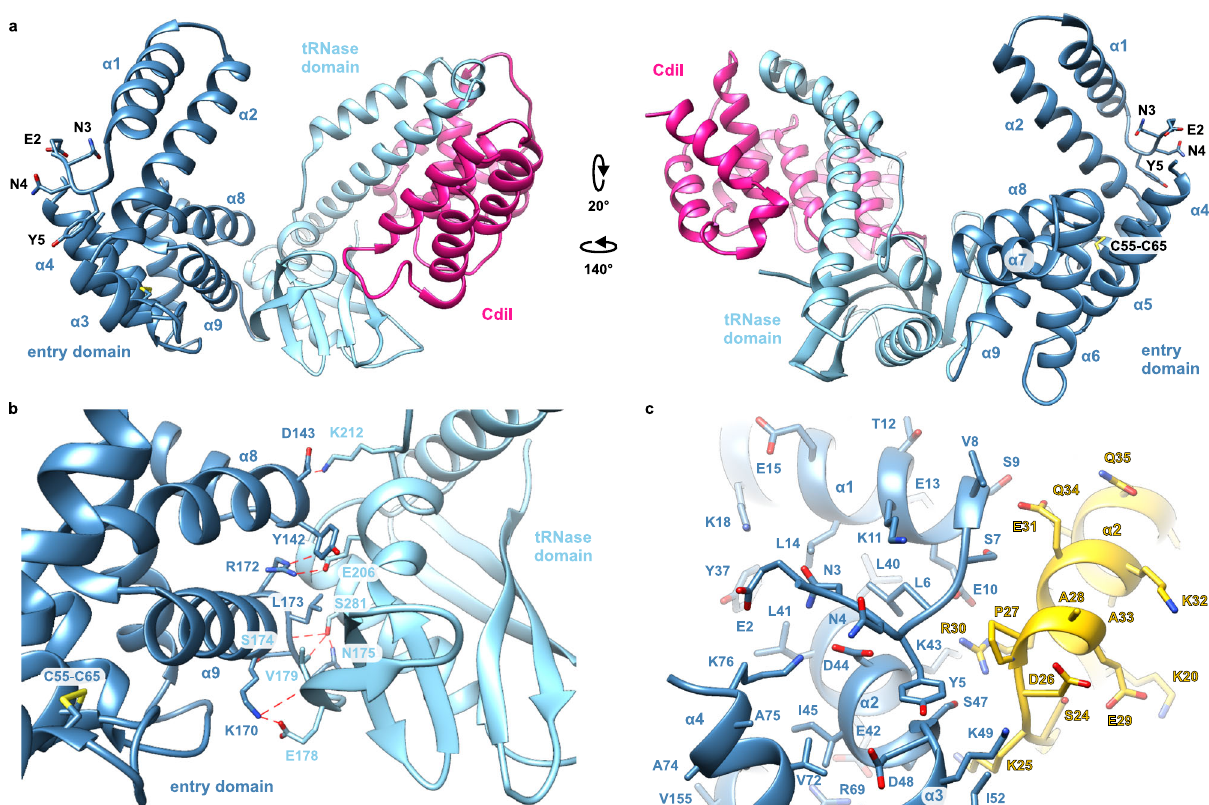
Fig.2|StructureofthePtsG-dependentcytoplasm-entrydomain.a Structureof the CdiA-CT (cid:129) CdiI EC3006 complex. CdiA-CT EC3006 is composed of an N-terminal cyto- plasm-entry domain (dark blue) and a C-terminal BECR tRNase (light blue). Side chains for Glu2, Asn3, and Asn4 (of the CdiA-CT EC3006 VENN motif) Tyr5 and the